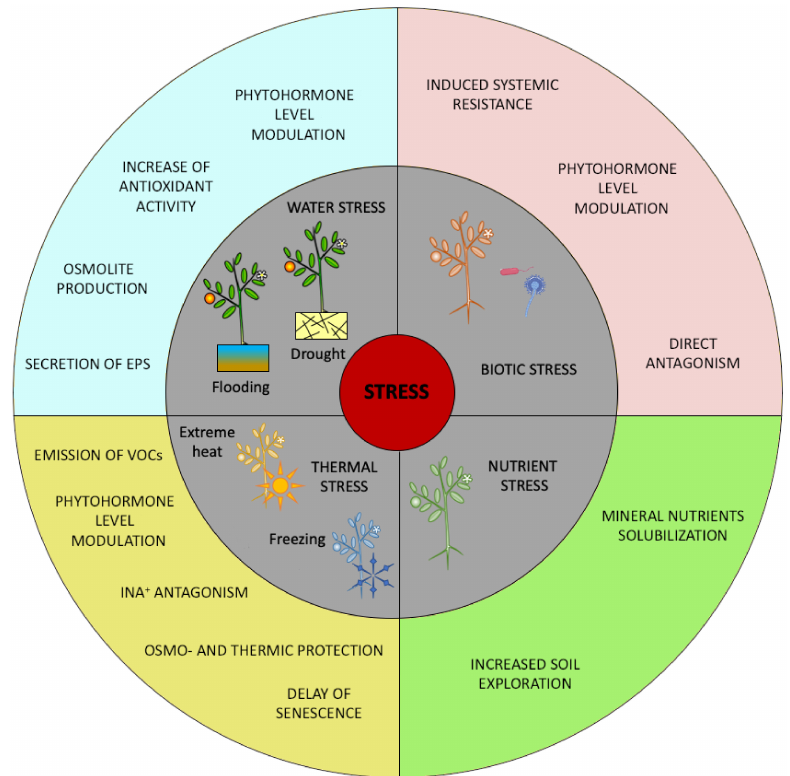
Figure 1. Schematic view of the protective mechanisms exerted by microbial biostimulants in relation to the stresses to which plants are subjected. Exopolysaccharides (EPS), Volatile Organic Compounds (VOCs), Ice-Nucleating Activity (INA +